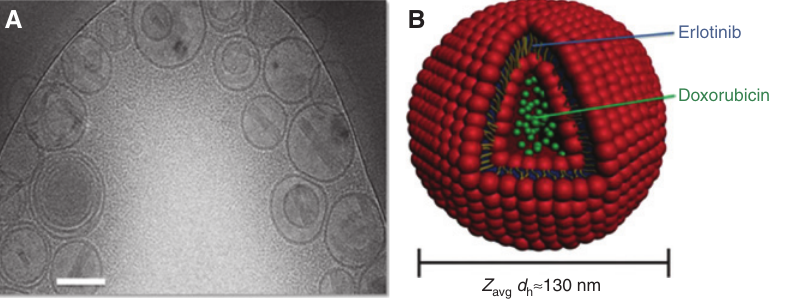
Figure 3: Cancer-fighting nanoparticles. (A) Cryo-TEM imaging and (B) illustration of double-whammy nanoparticles made by the Hammond and Yaffe laboratories. The particles deliver two different chemotherapeutic drugs in a sequence-controlled manner, with the first drug sensitizing cancer cells and increasing the potency of the second drug. Figure taken from Morton SW et al. A nanoparticle-based combina- tion chemotherapy delivery system for enhanced tumor killing by dynamic rewiring of signaling pathways. Sci. Signal. 2014, 7, ra44–ra44. Reprinted with permission from